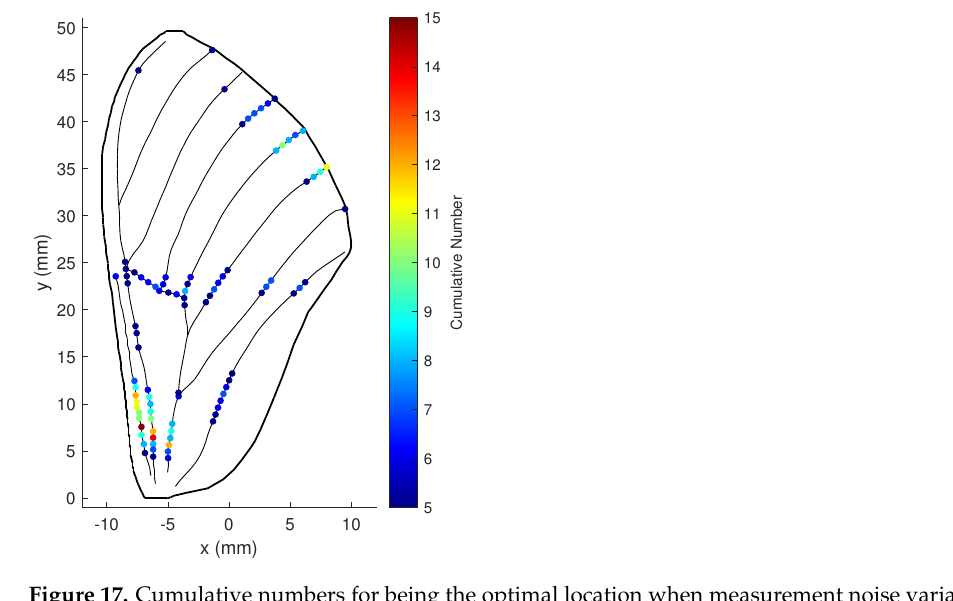
Figure 17. Cumulative numbers for being the optimal location when measurement noise variance is large: ω (cid:118) = 5, ω Υ = 100, and r =